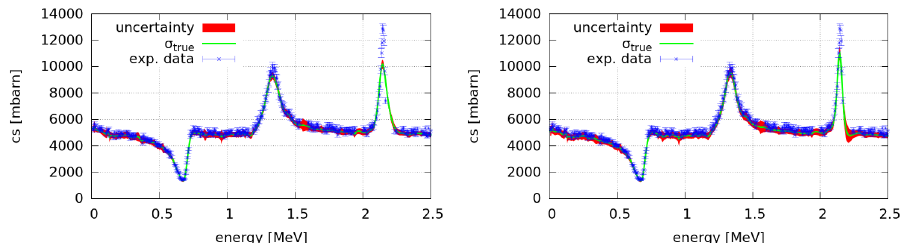
Figure 2. The true cross section σ true evaluated without (left) and with (right) model